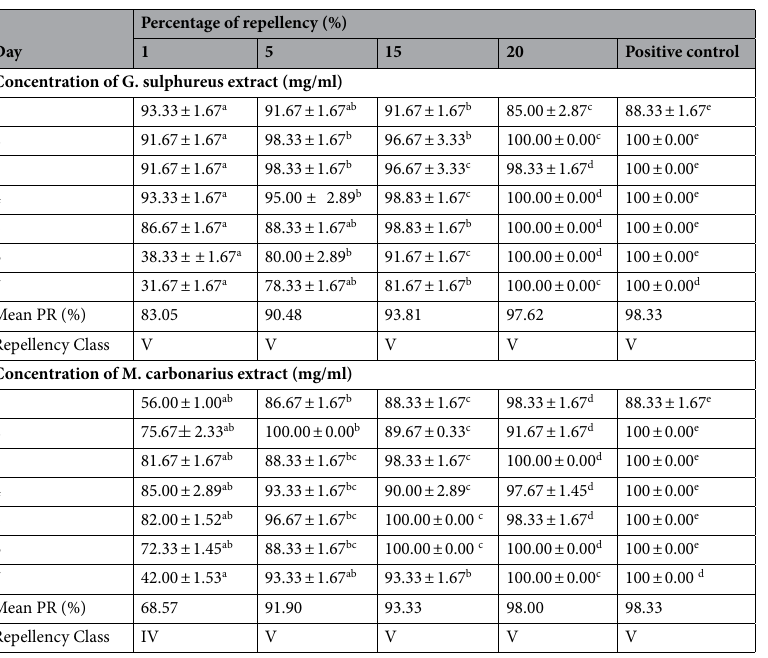
Table 2. Mean percentage repellency with the standard error and repellency class of Macrotermes carbonarius and Globitermes sulphureus extracts against Macrotermes gilvus . Different letters in the same row indicate a significant difference ( p < 0.05, Duncan’s test). Mean PR = mean percentage of repellency. Mean of three replicates (n = 30 termites per replicate). Repellency class = class 0 (> 0.01 to < 0.1%), nonrepellent; class I (0.1 to 20%), very weakly repellent; class II (20.1–40%), moderately repellent; class III (40.1–60%), averagely repellency; class IV (60.1 to 80%), fairly repellent; class V (80.1–100%), very